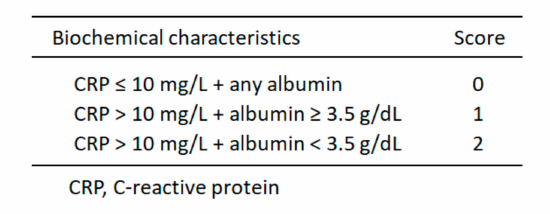
Figure 3. Modified Glasgow Prognostic Score